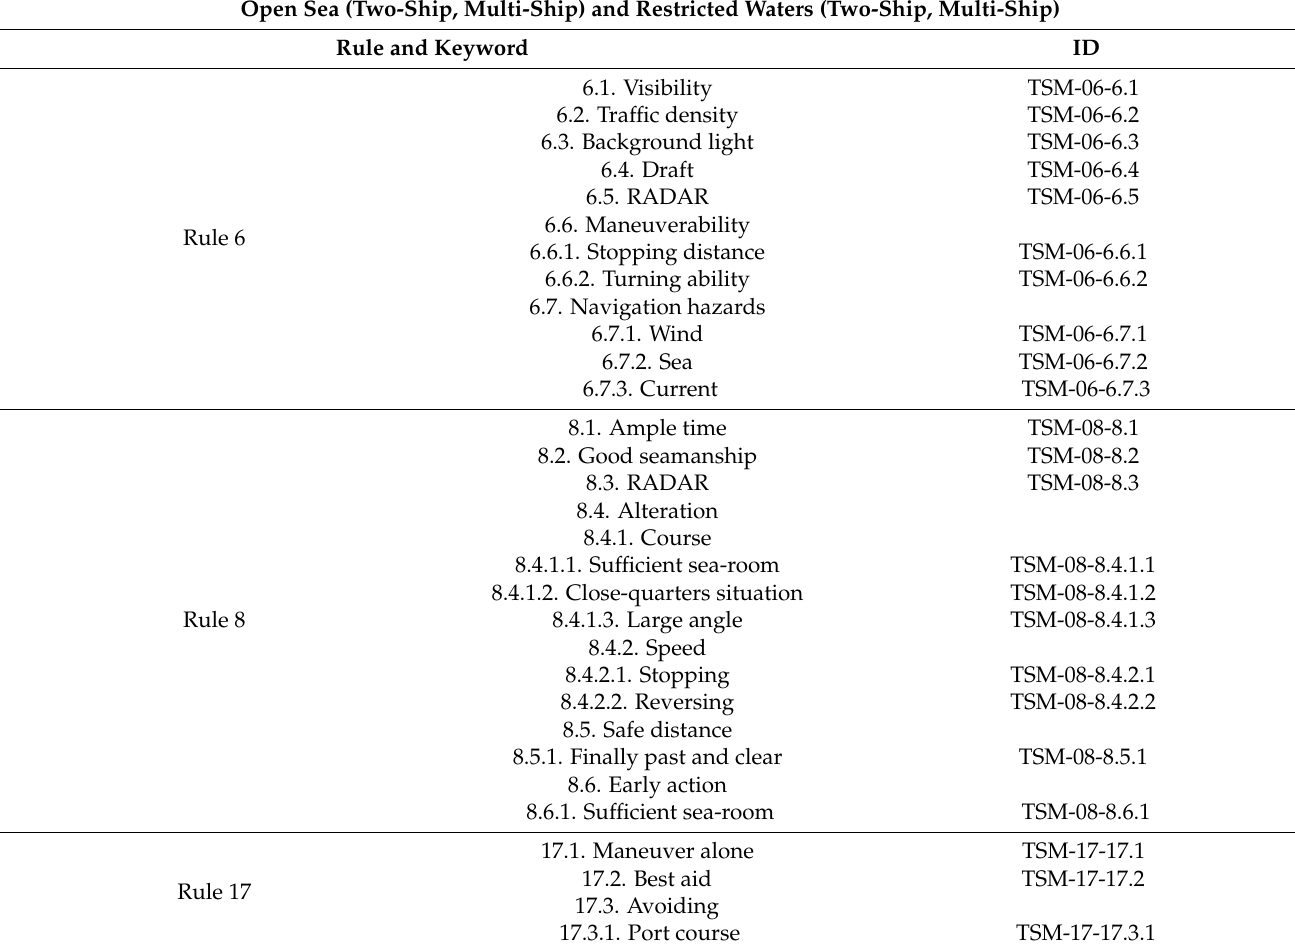
Table A4. Requirements specifications for target ship maneuverability.